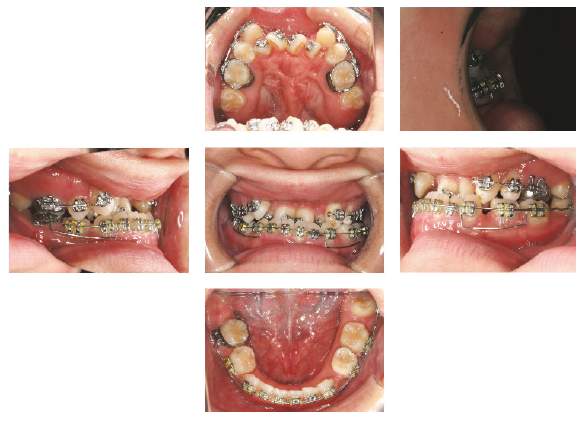
Figure 4: Intraoral photographs during predistraction orthodontic